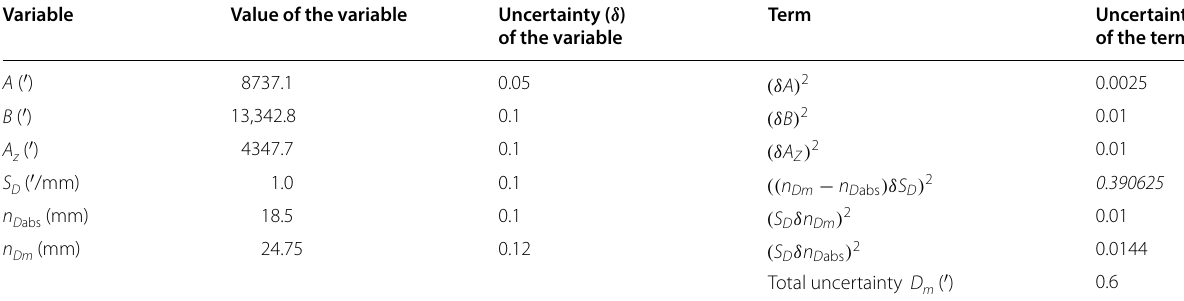
Table 2 Uncertainties for D